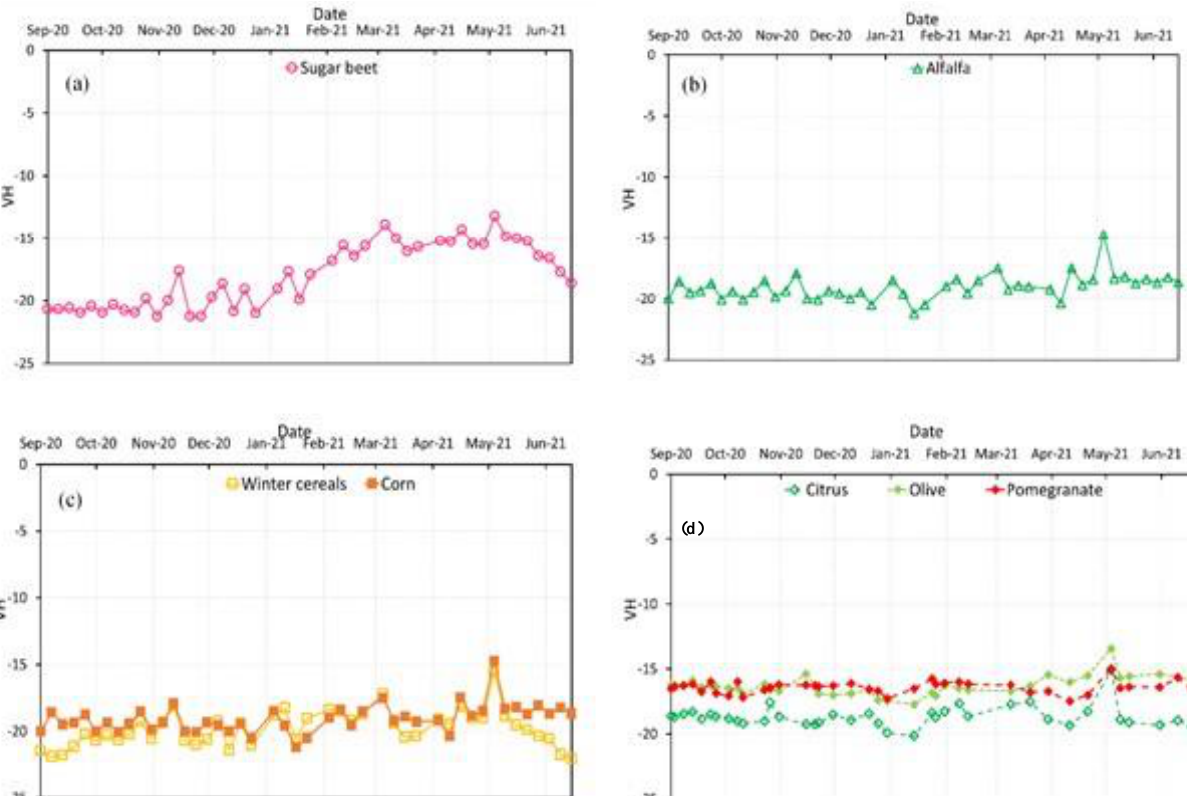
Figure 8. Backscattering spectral curves for major crop types planted in 2020/2021: ( a ) Sugar beet; ( b ) Alfalfa; ( c ) Winter cereals (wheat and barley) and corn; ( d ) Tree crops (pomegranates, citrus, and olive).